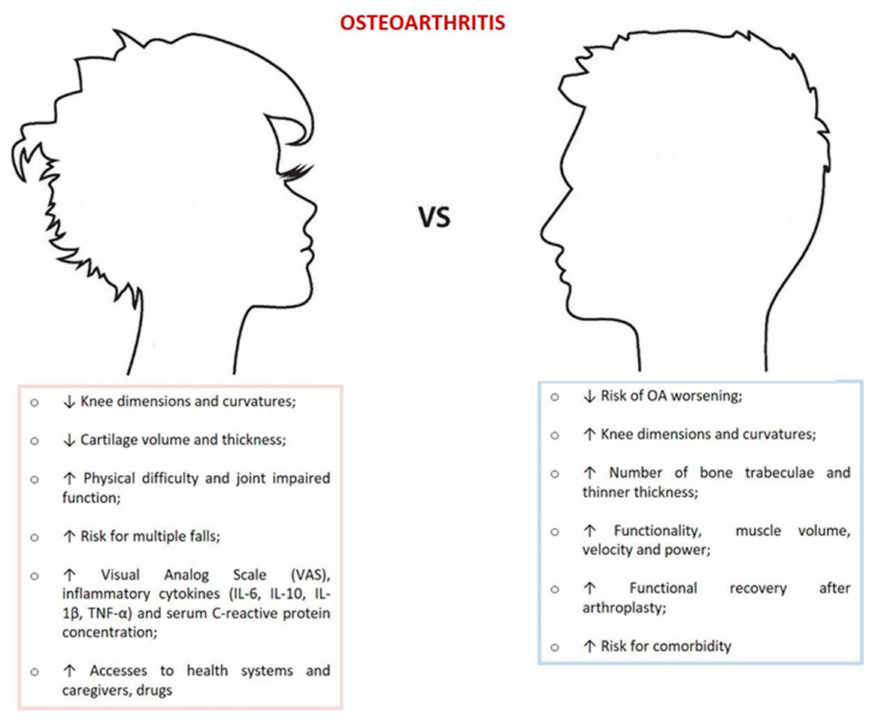
Figure 5. Major findings between men and women in